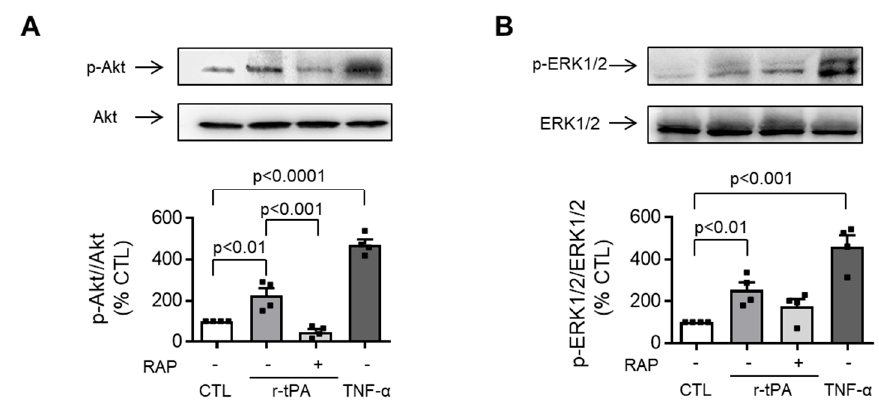
Figure 4. Pre-treatment with receptor-associated protein (RAP) inhibits PI3K/Akt phosphorylation induced by r-tPA while not affecting ERK1/2. Representative Western blot analysis and densitometric analysis of ( A ) Akt, and ( B ) ERK1/2 phosphorylation. Experiments were performed in polystyrene plates, cells were pre-treated for 1 h with 0.5 µM of RAP and stimulated with control medium (CTL) or 0.1 mg/mL r-tPA for 5 min, 200 U/mL of TNF- α was used as a positive control. Densitometric analysis was performed by dividing phospho-proteins to total amounts, afterwards data from the different group were normalized to their corresponding CTL and expressed as %. Mean ± 1 SEM, n = 4.